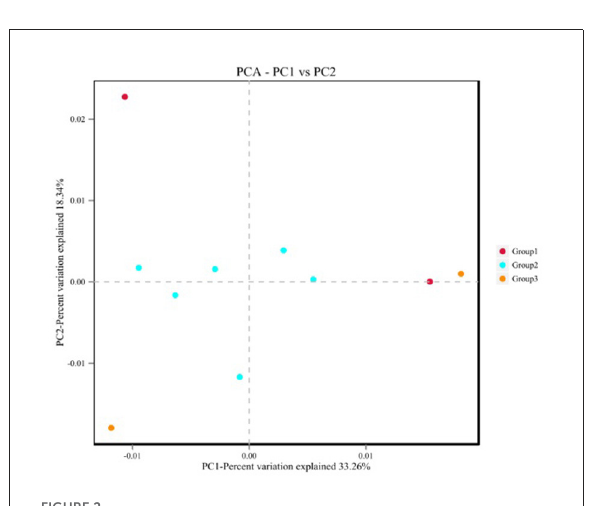
FIGURE2 Principal component analysis